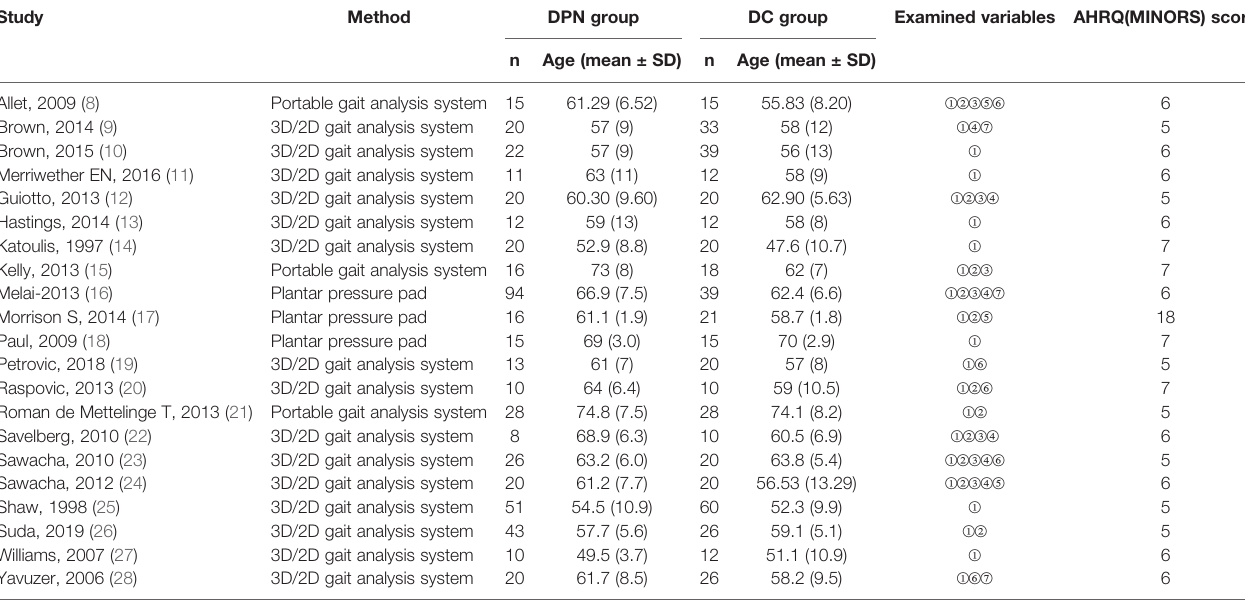
TABLE 1 | Overview and quality assessment of considered studies.